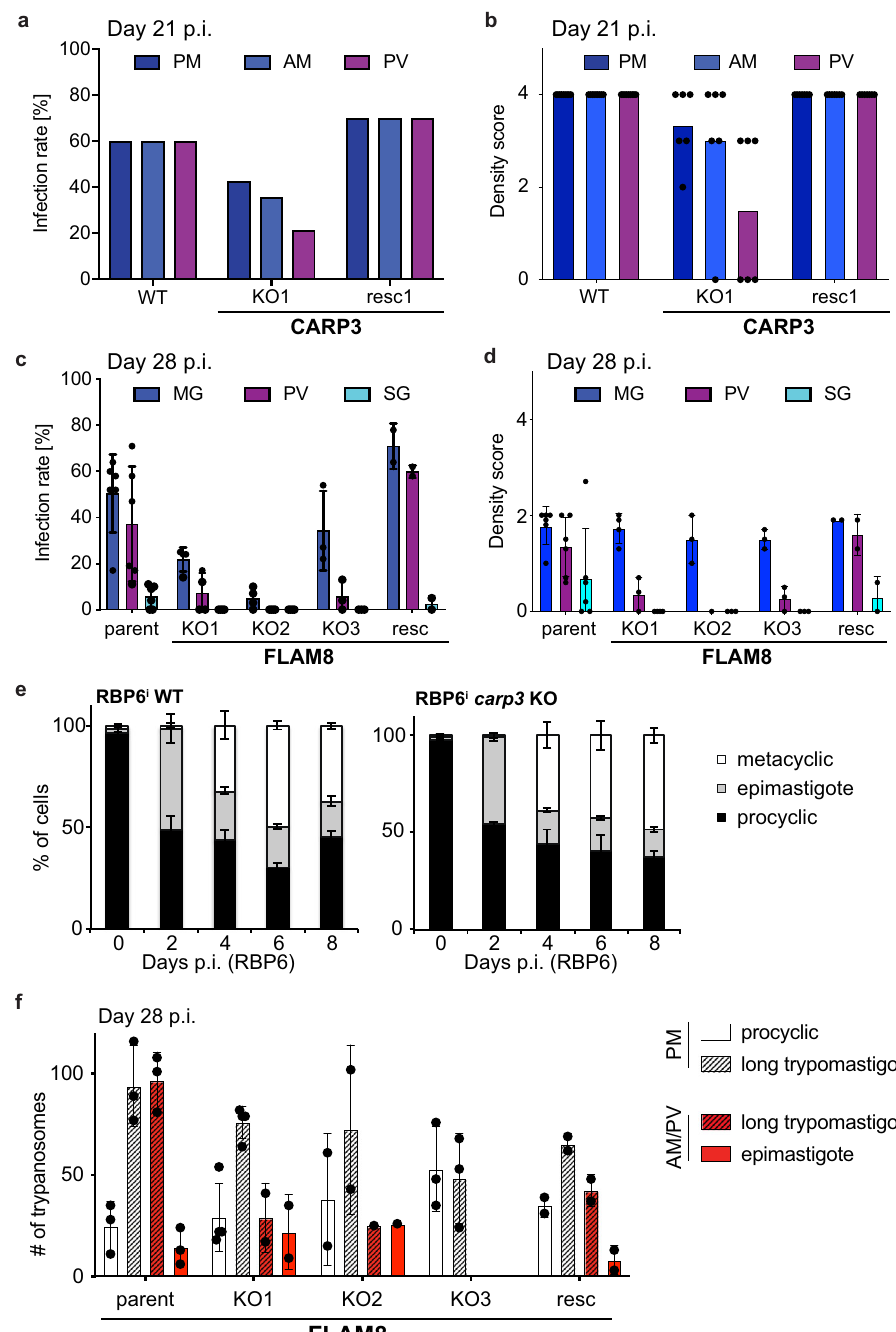
Fig. 4 | Development and fl y infection phenotypes of carp3 and fl am8 KO. 109(KO2);3,58(KO3);2,40(resc).Densityscoringasin( b ).Absolutetransmission ef fi ciencies differ between CARP3 and FLAM8 experiments due to different fl y colonies and parasite strains. e RBP6-induced development in carp3 KO and par- ental RBP6 line. Procyclic, epimastigote and metacyclic forms were classi fi ed according to morphology, kinetoplast position relative to nucleus (DAPI staining) and expression of stage-speci fi c marker proteins (see Supplementary Fig. 6). >100 cells were analyzed at each time point and replicate. Mean±SD of n =3. f Quanti fi cation of different developmental stages (procyclic, long mesocyclic trypomastigote,epimastigote)inPMorAM/PVoftsetse fl iesinfectedwith T.brucei AnTat 1.1E ‘ Paris ’ (parent), fl am8 KO (subclones KO1, KO2, KO3) or FLAM8